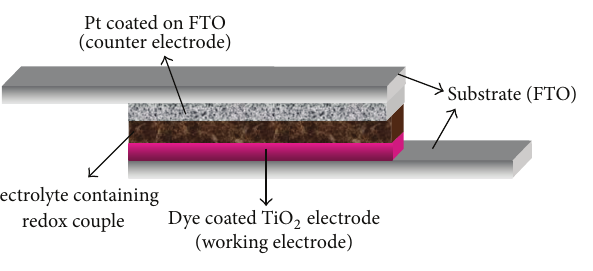
Figure 1: Sandwich type assembly of DSSCs.